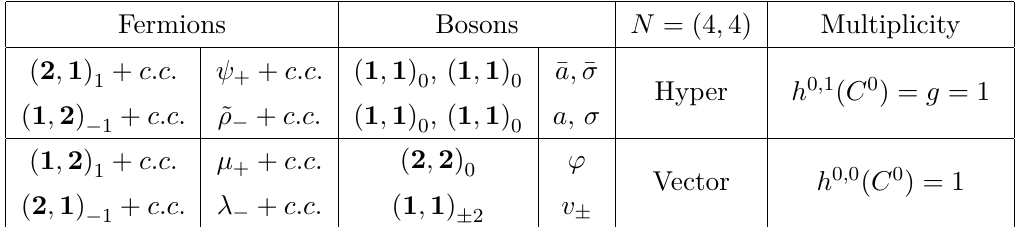
SU(2) SO(1 , 1) . We denote by + / − the L × R ×